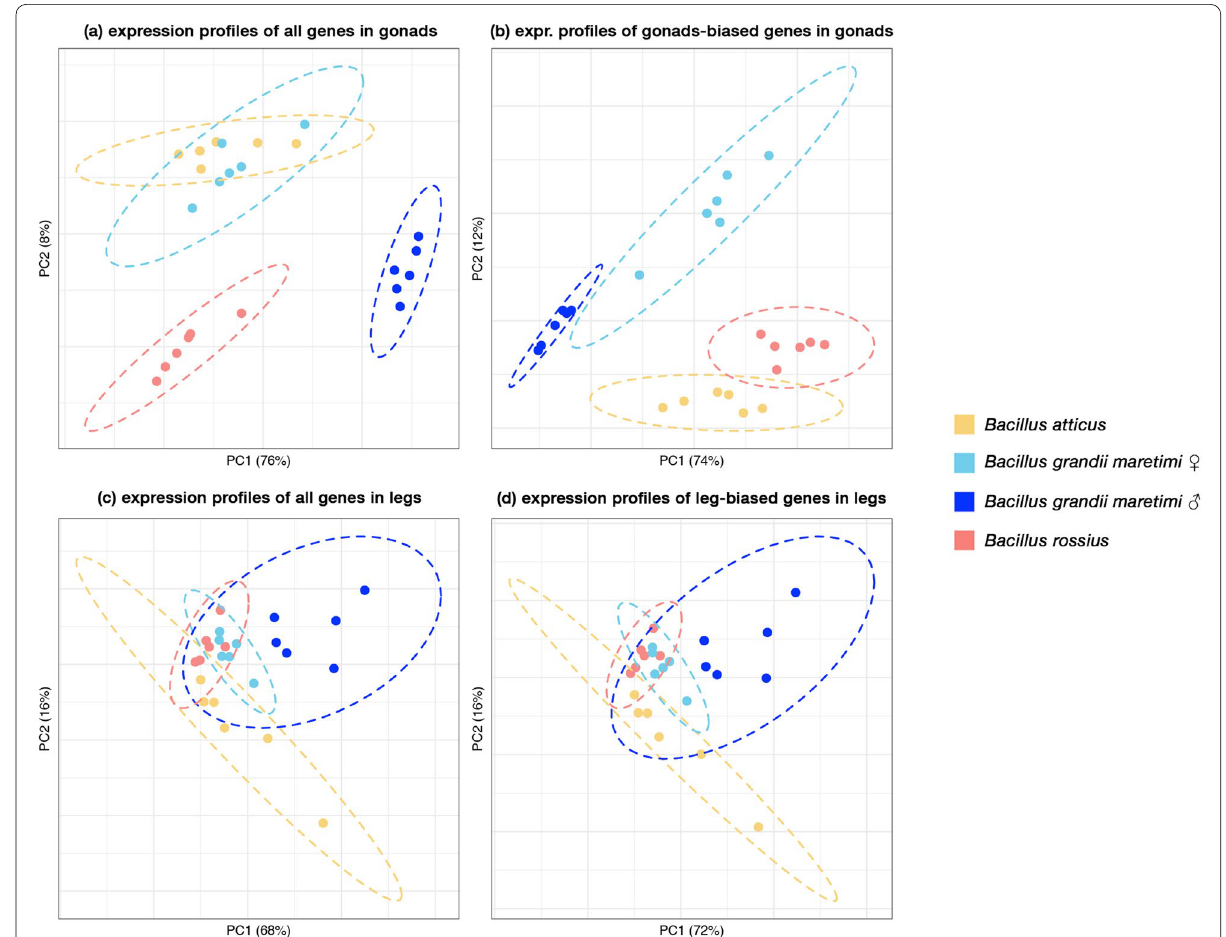
Fig. 3 PCA analysis on the TMM normalized gene expression values for a all genes in gonads samples, b gonads-biased genes in gonads samples, c all genes in legs samples, (b) legs-biased genes in legs